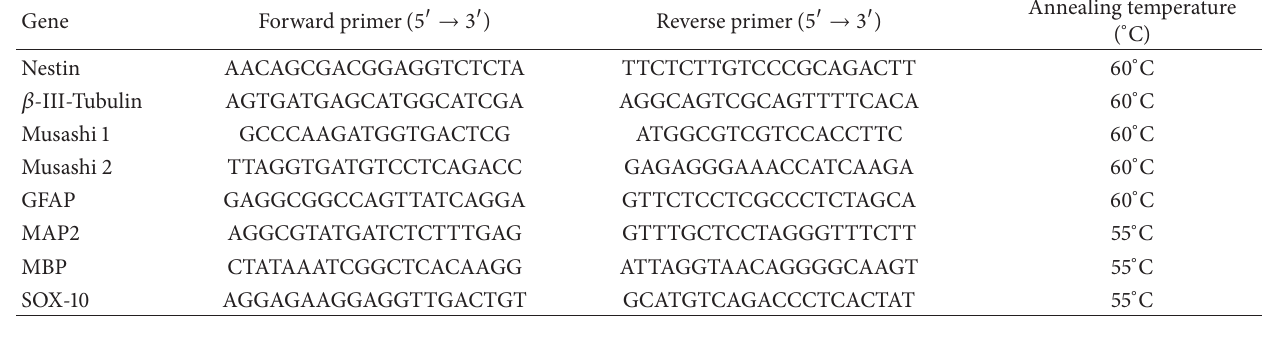
Table 1: Primer sequences for real-time PCR.